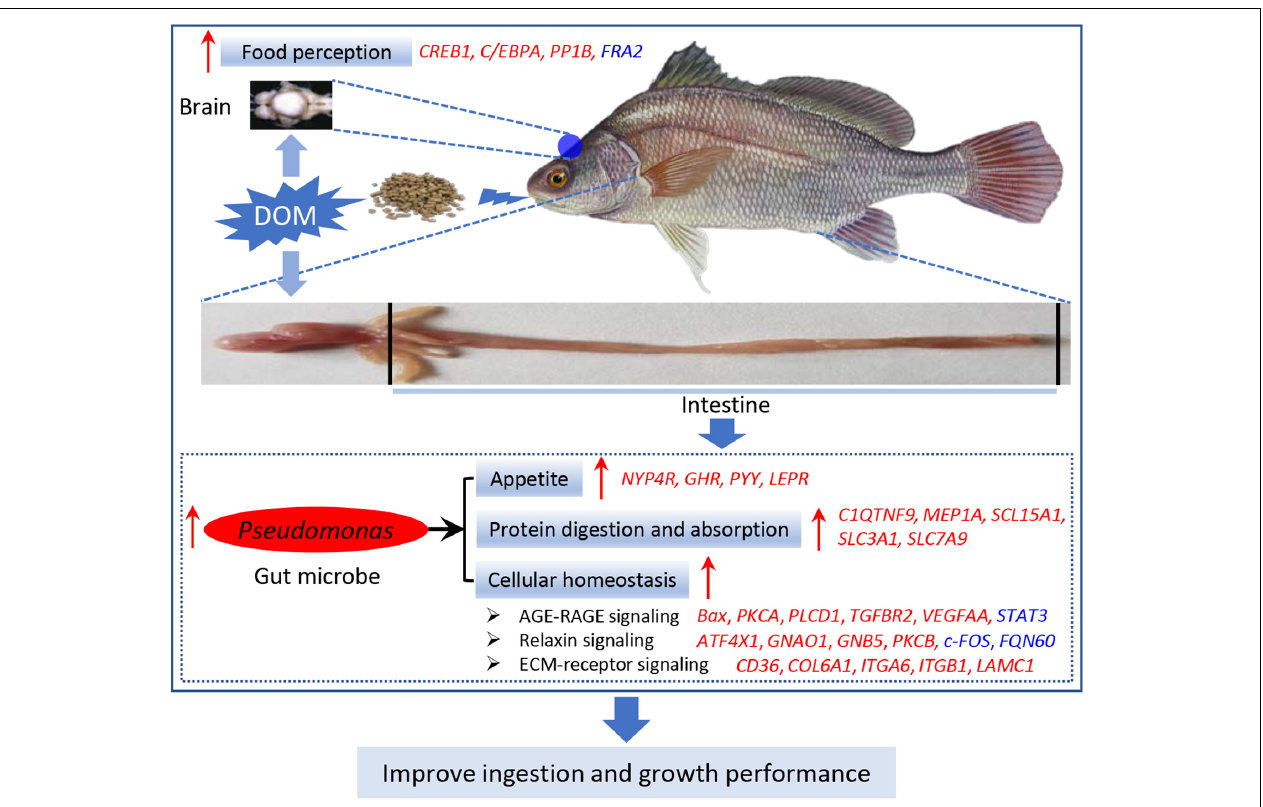
FIGURE 9 | Hypothetical schematic of Pseudomonas- mediated ingestion and growth performance regulated by feed domestication in A. grunniens . Hypothetical regulation of Pseudomonas on ingestion and growth performance was raised based on the results in this study. Feed domestication improved feed perception in the brain tissue, thereby transducing the signal to the intestine. In the intestine, DOM improved the abundance of microbiota of Pseudomonas , eventually improving the ingestion and growth performance by enhancing appetite, protein digestion and absorption, and cellular homeostasis capacity. Arrows in red color represent the positive regulation or activation, italic letters in red color represent the upregulated genes, and italic letters in blue color represent the downregulated